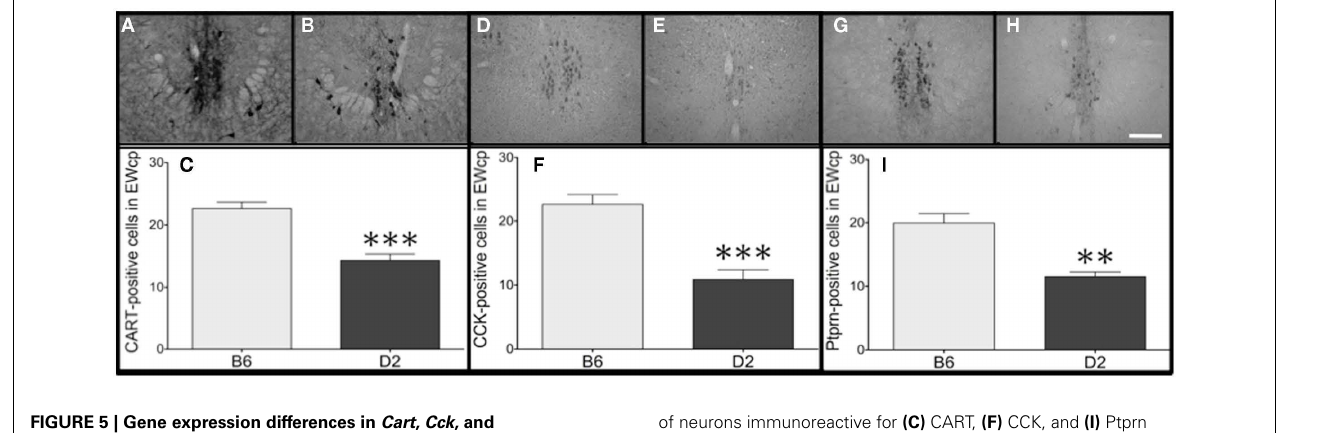
FIGURE 5 | Gene expression differences in Cart , Cck , and Ptprn are verified at the protein level. Representative images from the EWcp ( − 3.4 to − 3.6mm from bregma) of B6 mice (A,D,G) and D2 mice (B,E,H) .Within the EWcp, greater numbers